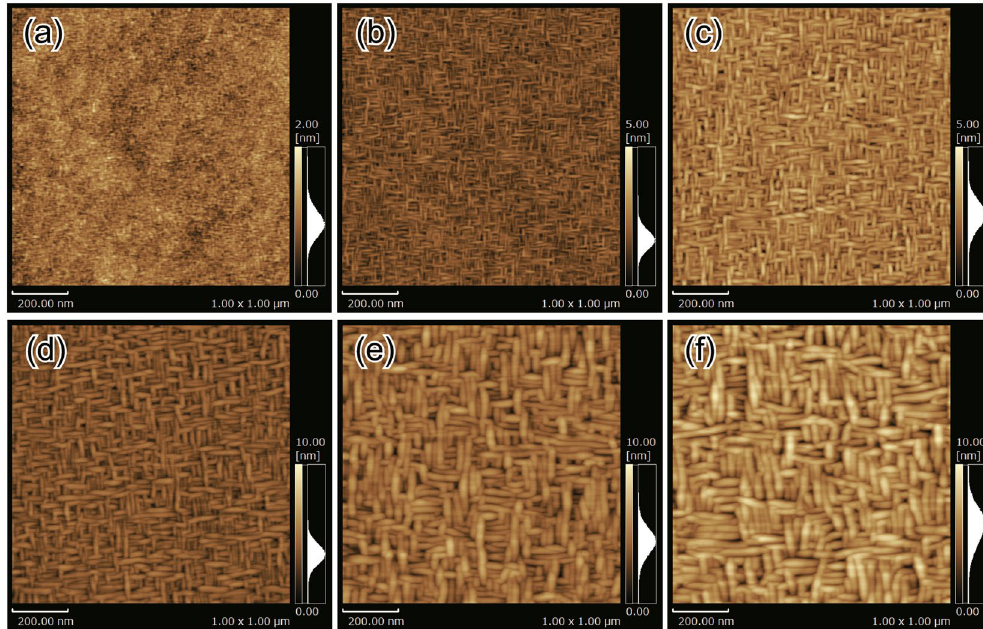
Figure 3. Surface AFM images of NbTi alloy thin films. The vertical and horizontal directions of the images are showed in accordance with [010] and [100] directions of STO (001) substrates, respectively. The film thicknesses are ( a ) 10 nm, ( b ) 50 nm, ( c ) 100 nm, ( d ) 200 nm, ( e ) 400 nm, and ( f ) 600